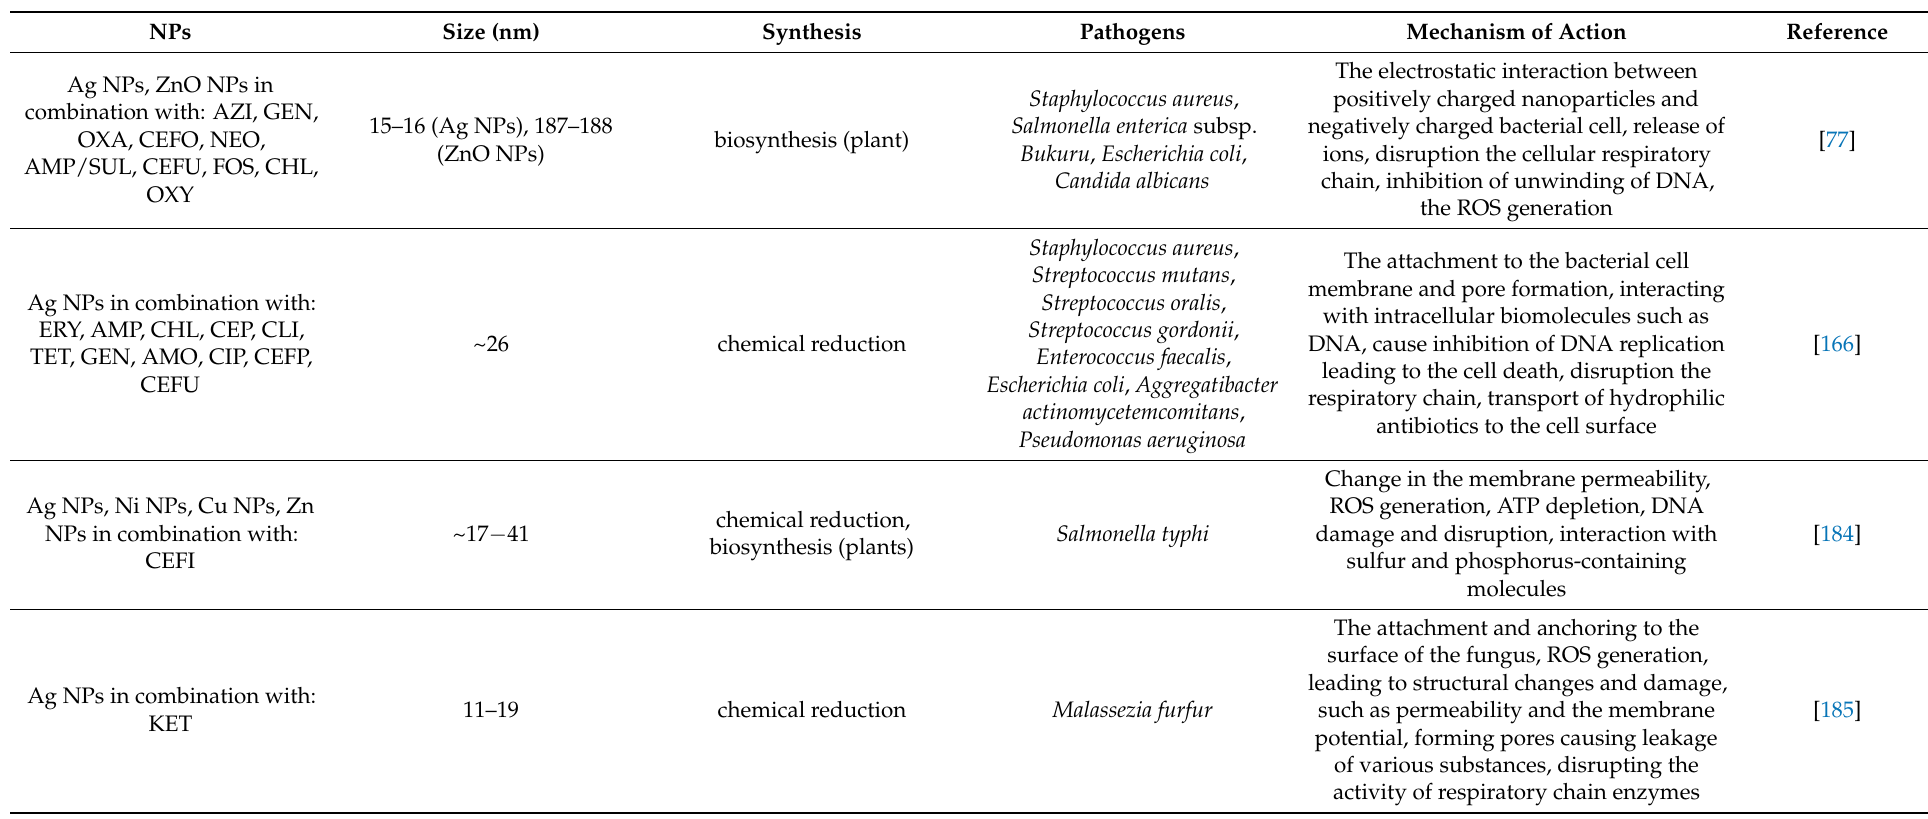
Table 2. Antimicrobial activity of metallic NPs in combination with conventional antibiotics/fungicides or compounds other than antimicrobial agents. Abbreviations: Ni, nickel; Cu, Copper; Zn, zinc; AZI, azithromycin; GEN, gentamycin; OXA, oxacillin; CEFO, cefotaxime; NEO, neomycin; AMP, ampicillin; SUL,